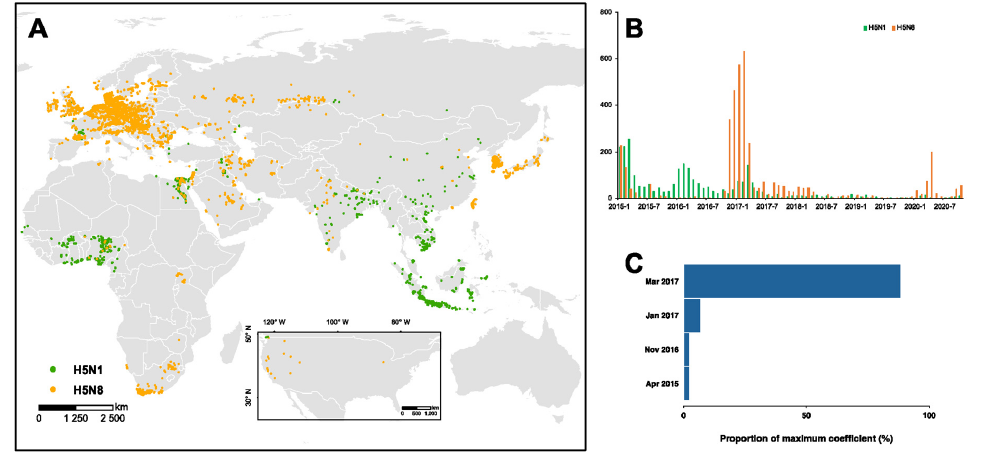
Figure 1. H5N1 and H5N8 outbreaks in 2015–2020. ( A ) Spatial and ( B ) temporal distribution of the two subtypes on the globe. ( C ) The timing of the maximum correlation of the dynamics of two subtypes is identified by correlation analysis. Across the vast range of the window size for the correlation analysis, the distribution of the timing for maximum coefficient is presented.